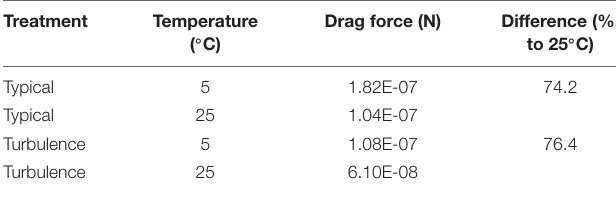
TABLE 4 | Absolute drag forces and drag force